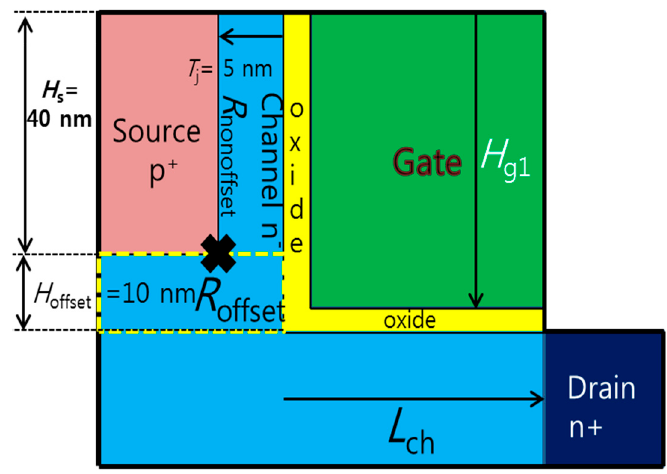
Figure 1. Schematic of the L-shaped tunneling field-effect-transistor (LTFET).